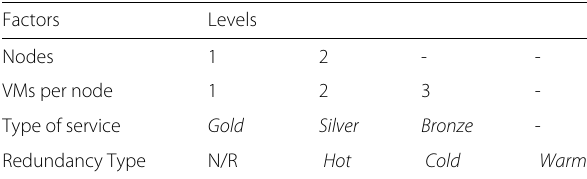
cloud environment